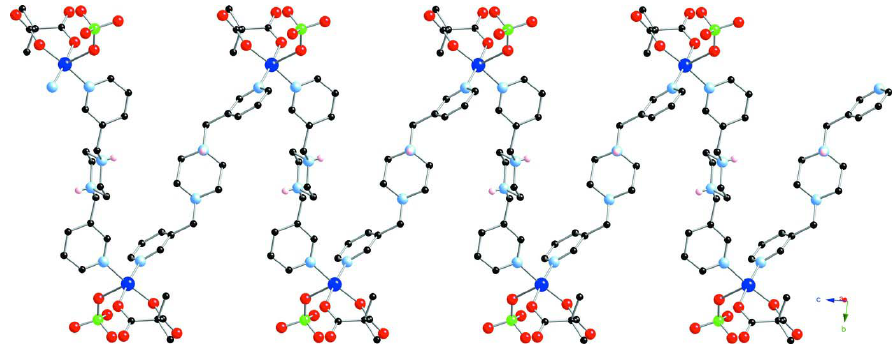
Figure 2 A single cationic [Cu(dimethylmalonate)(ClO